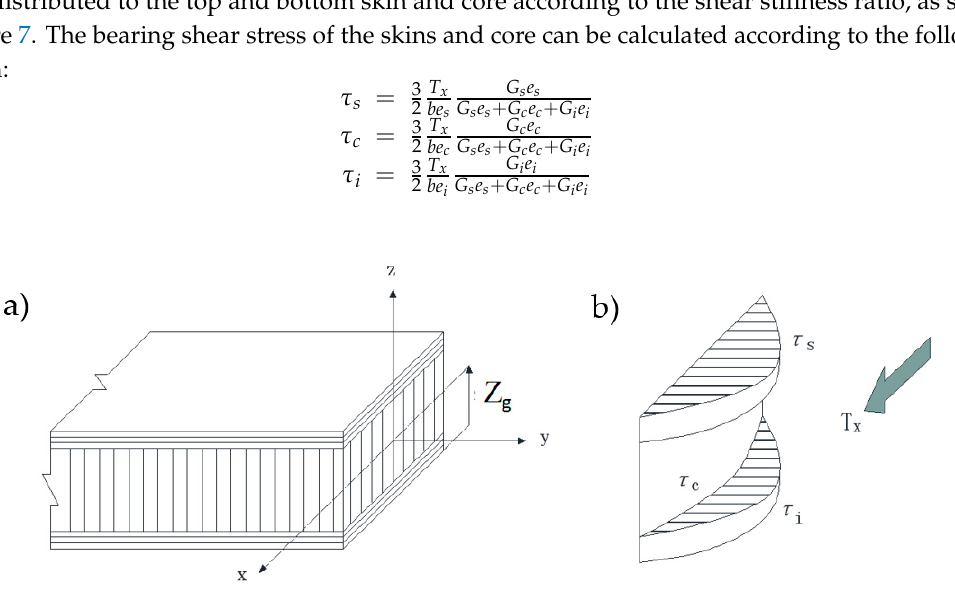
Figure 7. Stress distribution of sandwich structure under in-plane shear load: ( a ) coordinate system; ( b ) shear stress diagram.